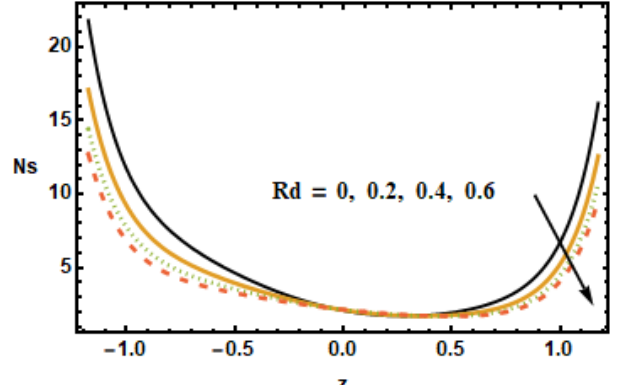
Figure 22. Effects of radiation parameter Rd on Ns .